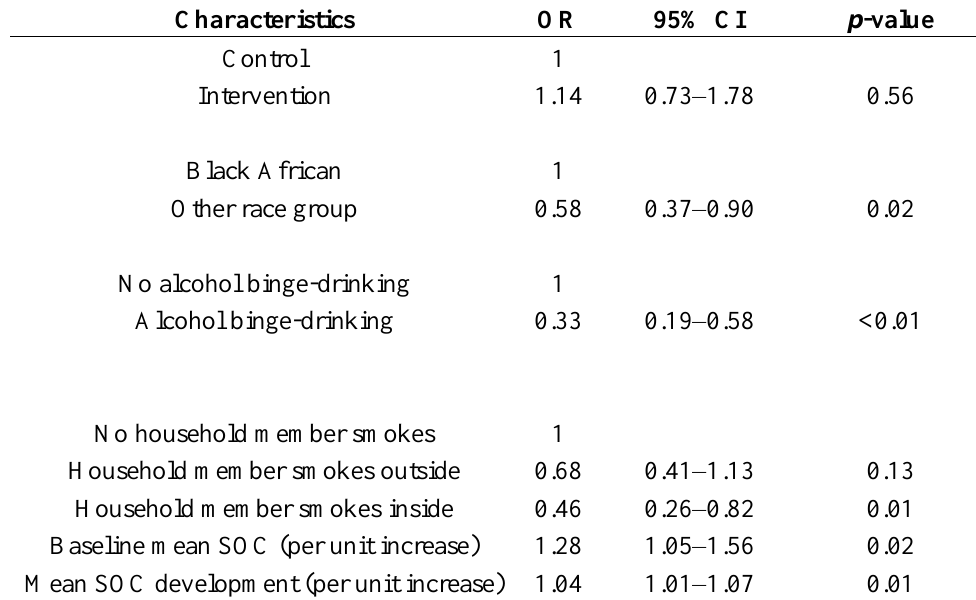
Table 2. Final logistic regression model of factors independently associated with adolescents’ commitment to a smoke-free